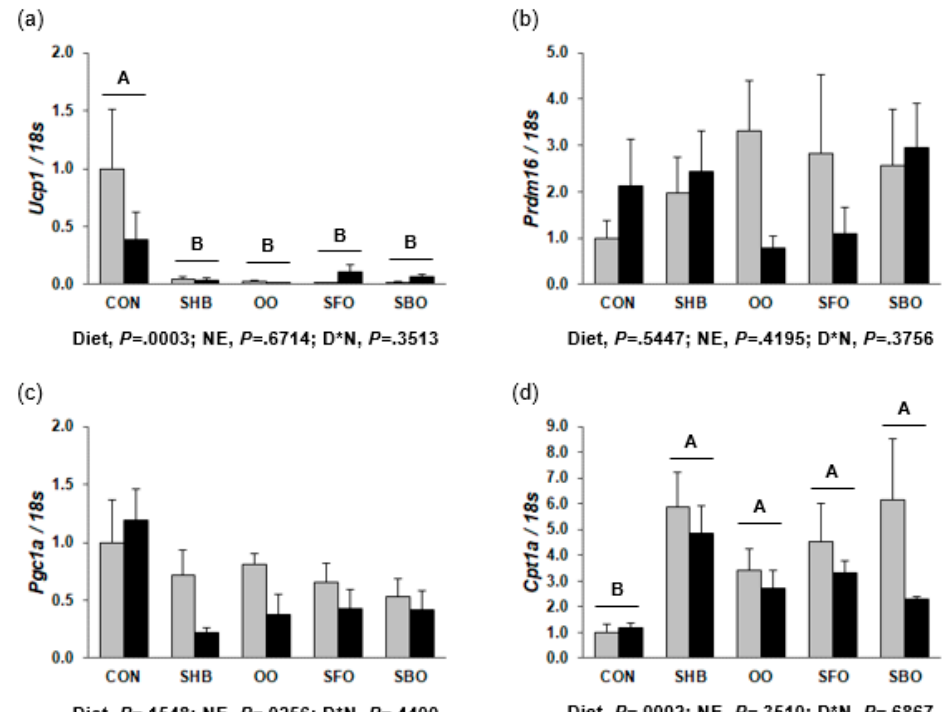
Figure 4. Expression of genes involved in thermogenesis in subcutaneous WAT ( a ) Ucp1 ( b ) Prdm16 ( c ) Pgc1a ( d ) Cpt1a . Mice were injected with norepinephrine (NE; 2 mg/kg body weight) or phosphate-buffered saline (PBS; 2 mL/kg body weight) as a vehicle after 8-h fasting at the end of the experimental period, and euthanized after another 4-h fasting. Gene expression was determined by RT-PCR. Data are presented as means ± SEM ( n = 8 for each diet group; n = 4 each for PBS and NE). Diets were compared among each other (after combining PBS and NE data within each diet), and assigned different superscripts A or B) if they were significantly different from each other at P < 0.05 by Tukey’s multiple comparison test. If a diet has a common superscript with another diet, it means they are not significantly different from each other. Only diets without a common superscript are significantly different from each other. D*N, Interaction effect between diet and NE. CON, control; SHB, shea butter; OO, olive oil; SFO, safflower; SBO, soybean oil.